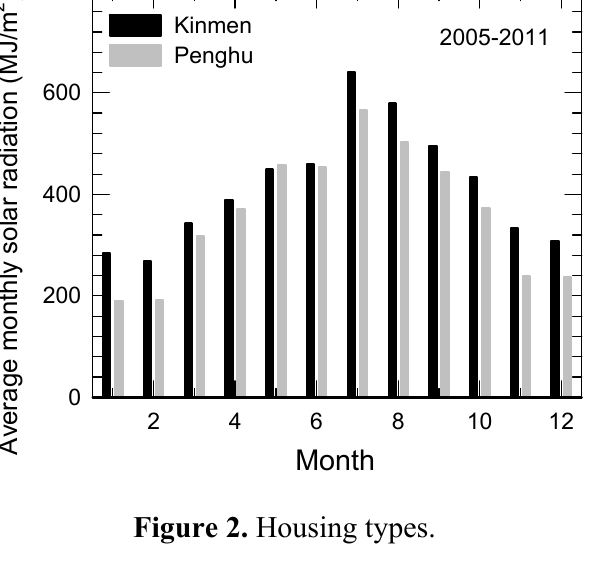
Figure 1. Monthly solar radiation per A